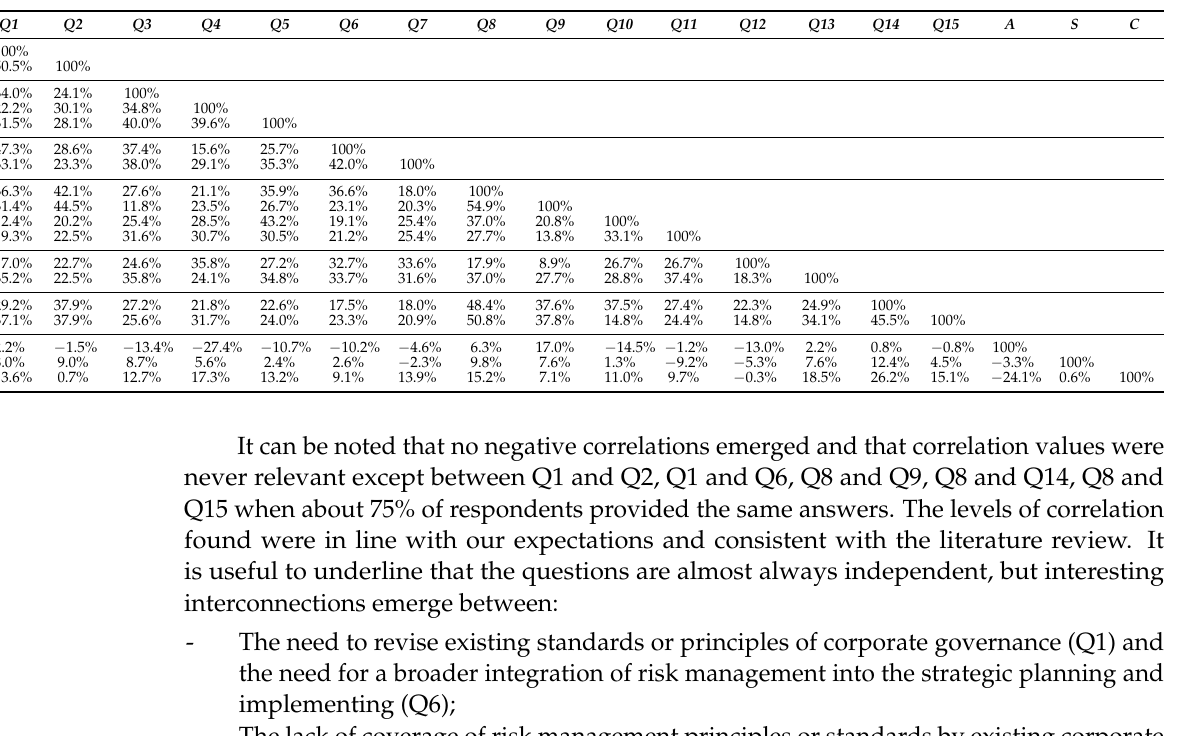
Table 1. Correlation